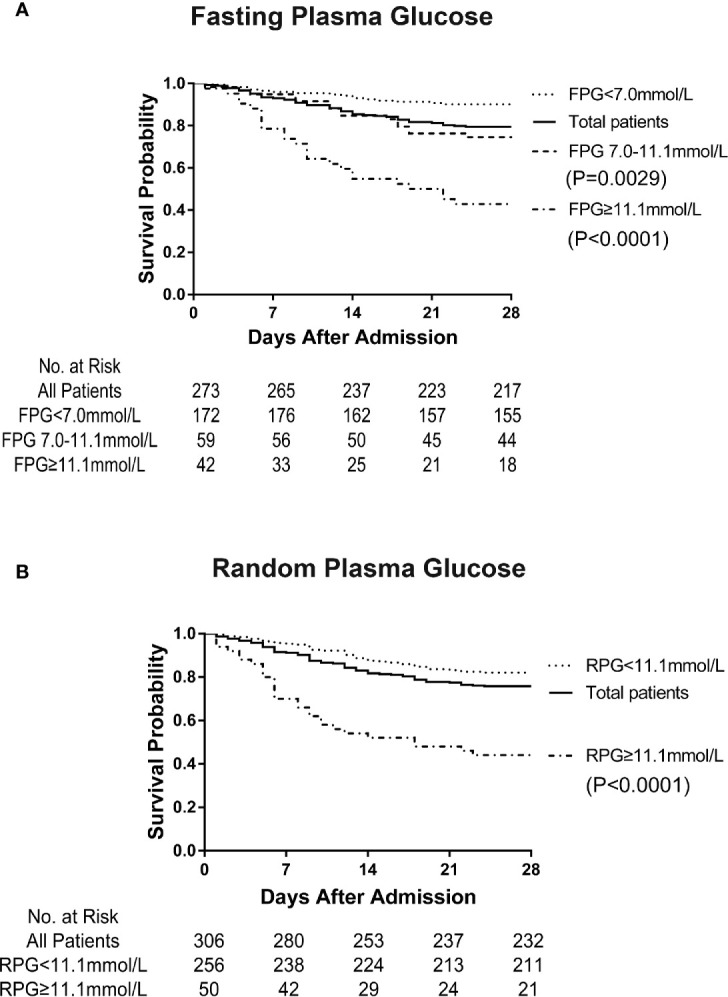
Survival curve of patients with COVID-19 affected by fasting plasma glucose (FPG) and random plasma glucose (RPG) levels on admission. It shows the greatly decreased survival in patients with FPG level ≥ 7.0 mmol/L on admission compared with that in patients with FPG level < 7.0 mmol/L (p < 0.0001) (A). It indicates the obviously decreased survival in patients with RPG level ≥11.1 mmol/L on admission compared with that in patients with RPG level <11.1 mmol/L (p < 0.0001) (B).